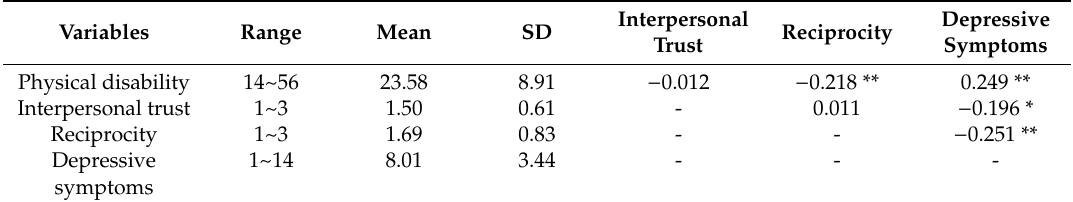
Table 2. Descriptive statistics and Pearson correlation analysis.